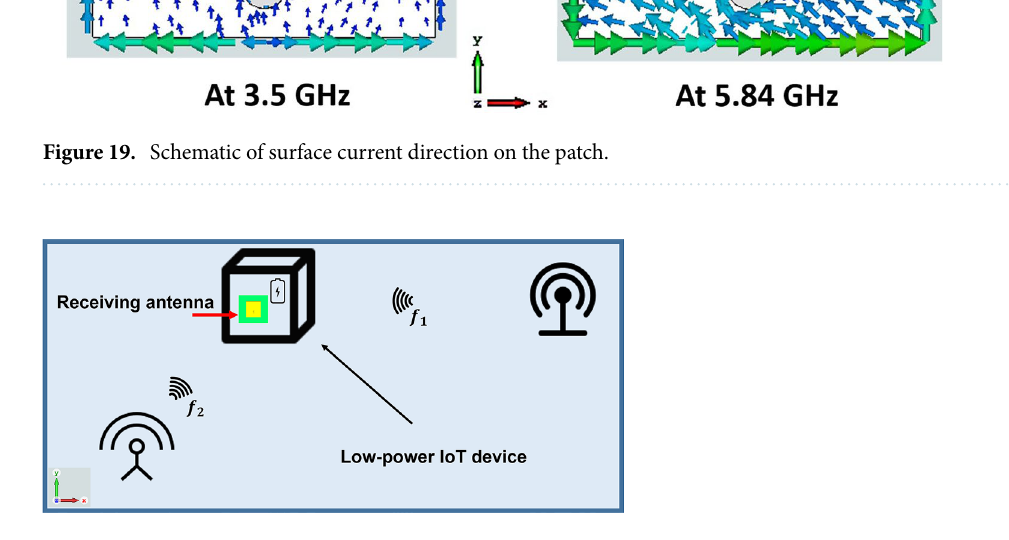
Figure 20. Schematic of potential applications of the proposed dual-band, dual pattern